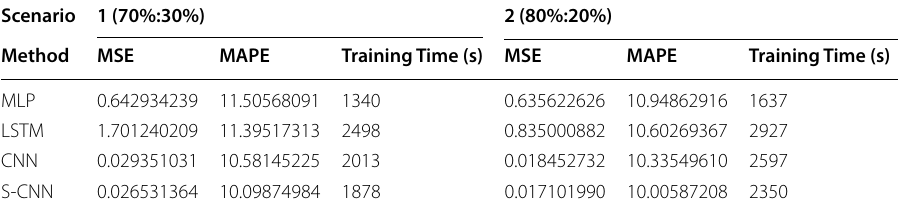
Table 11 Forecasting comparison